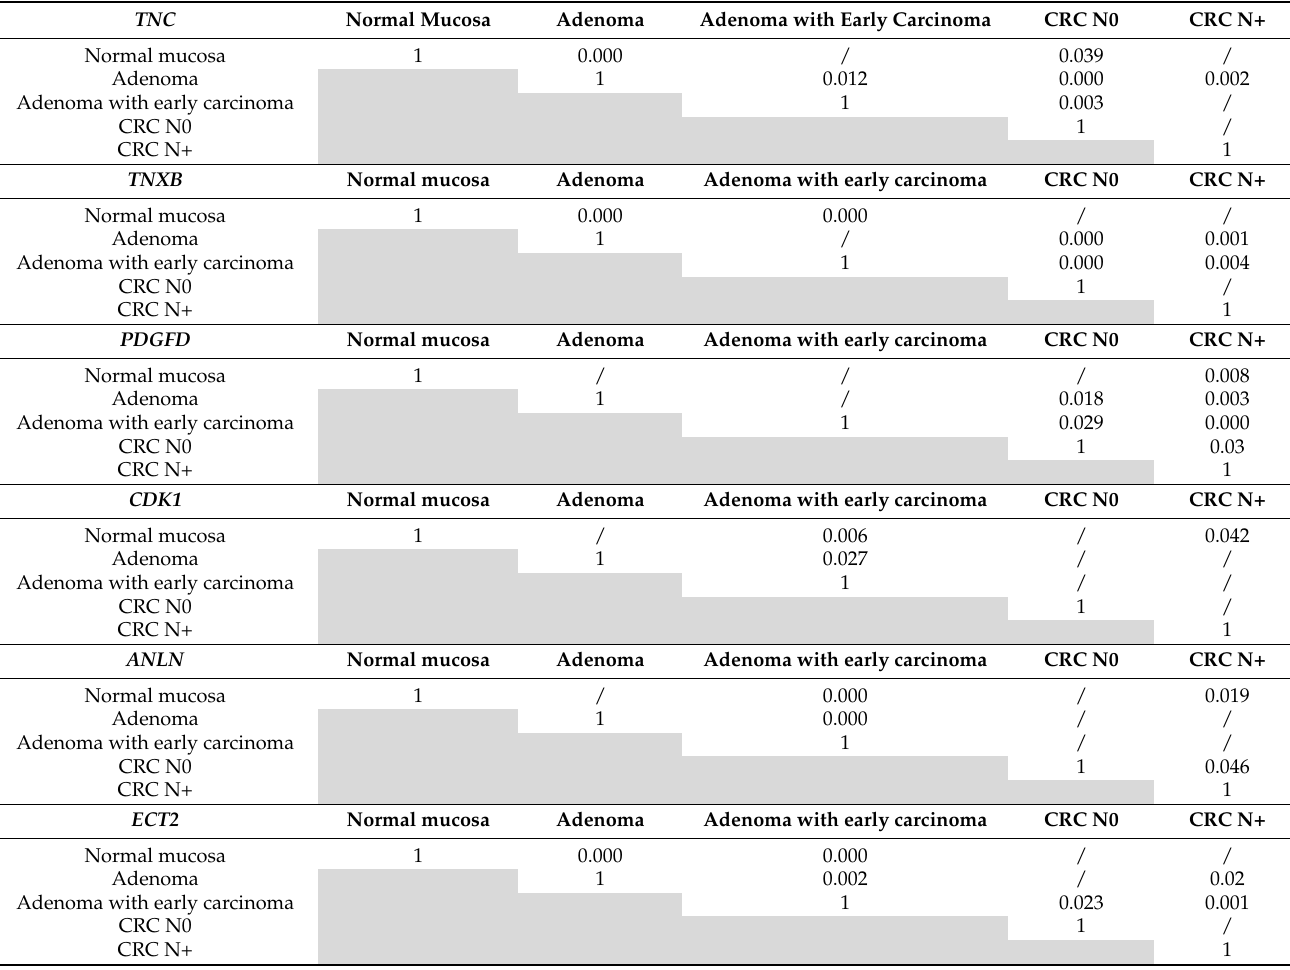
Table 2. All statistical comparisons for the investigated